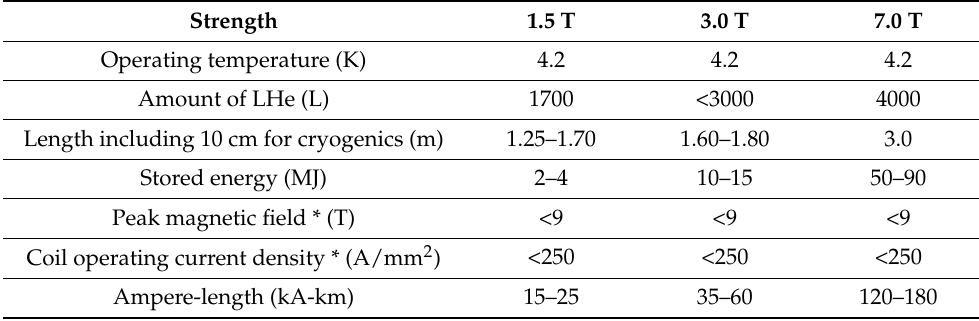
Table 2. MRI magnet design guidelines